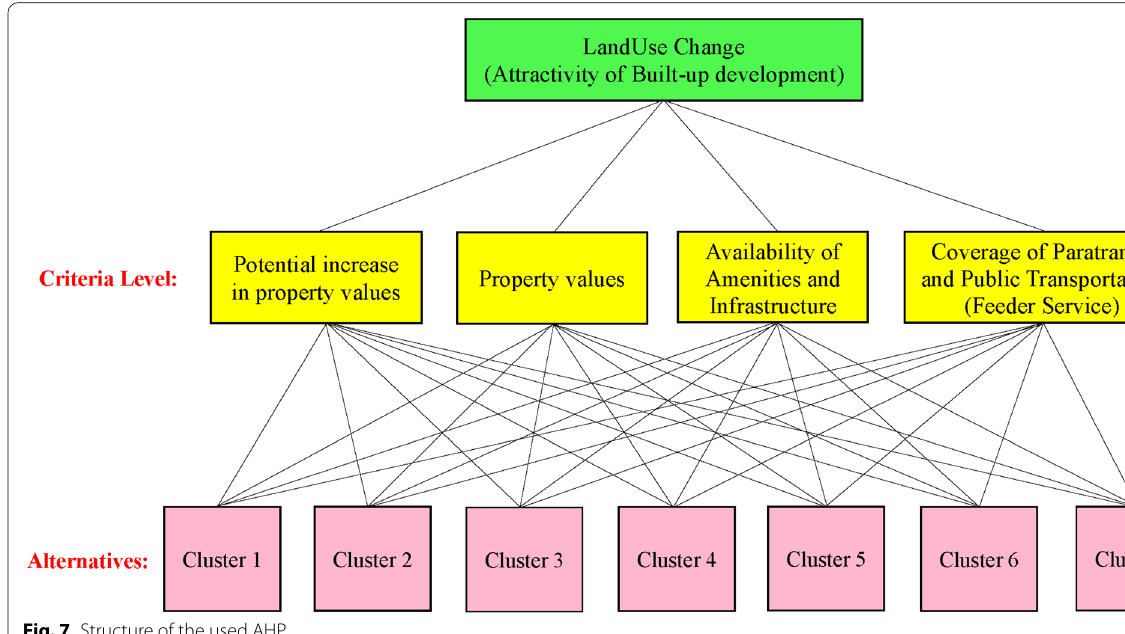
Fig. 7 Structure of the used AHP